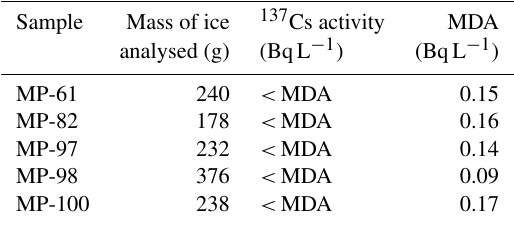
Table 1. Concentrations of 137 Cs in the soluble water fraction of ice from Monte Perdido samples. MDA: minimum detection